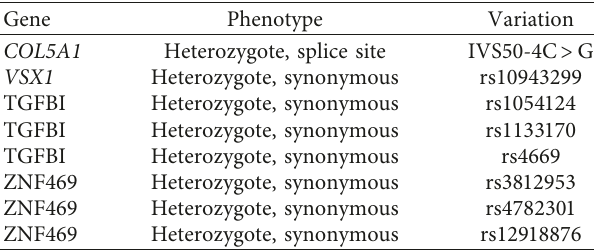
Table 2: Preliminary KC candidate